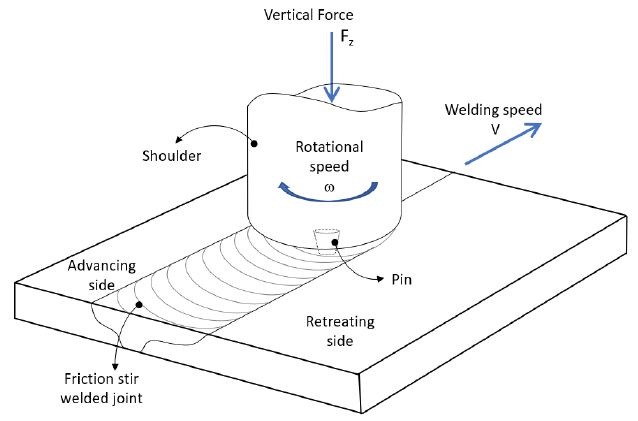
Figure 1. Scheme of FSW process.